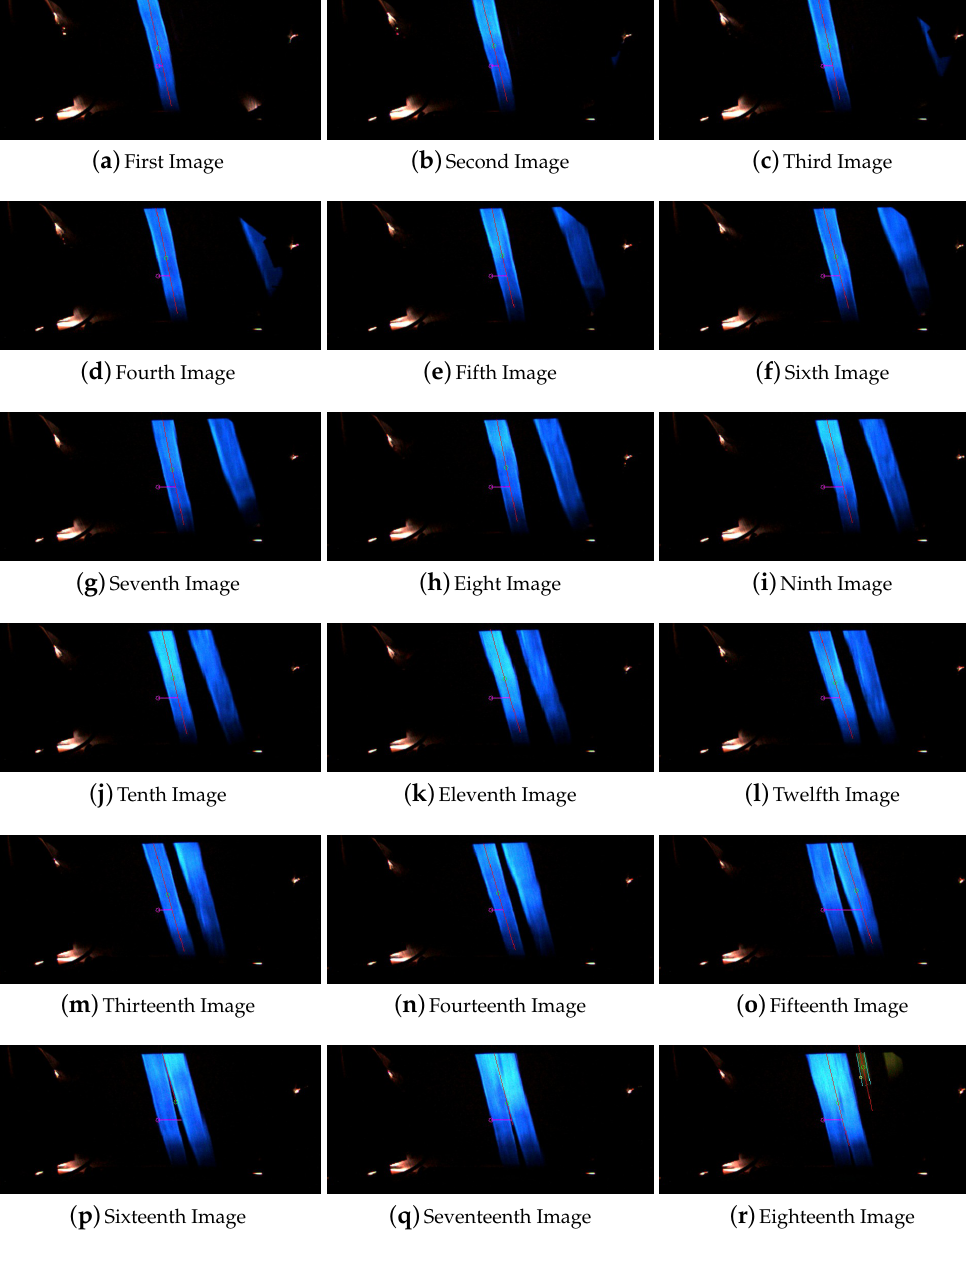
Figure 17. Sequence of images captured overpassing a fork or branch